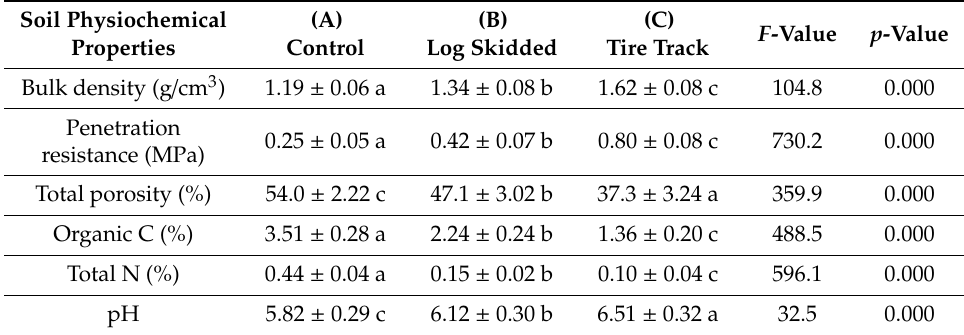
Table1. SoilphysiochemicalpropertiesonthreeareasandANOVAandDuncantestresults(Mean ± SD). Soil